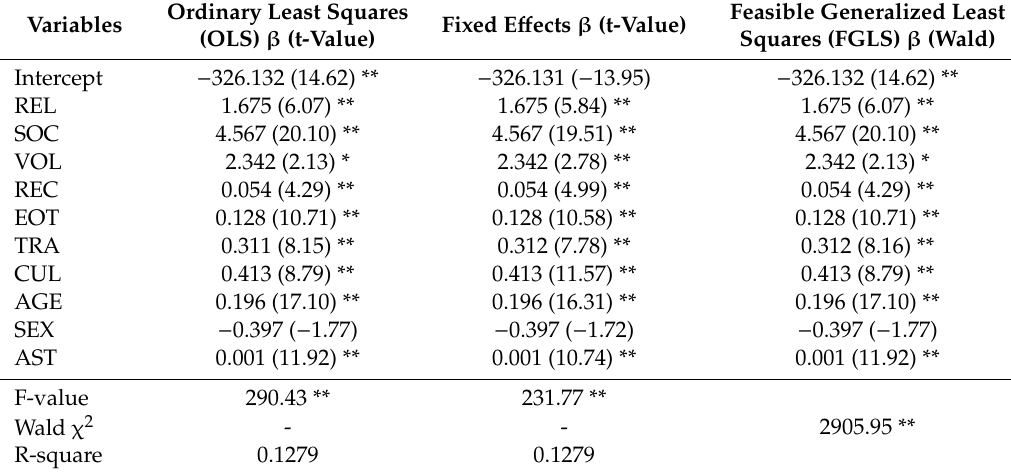
Table 3. Regression analysis